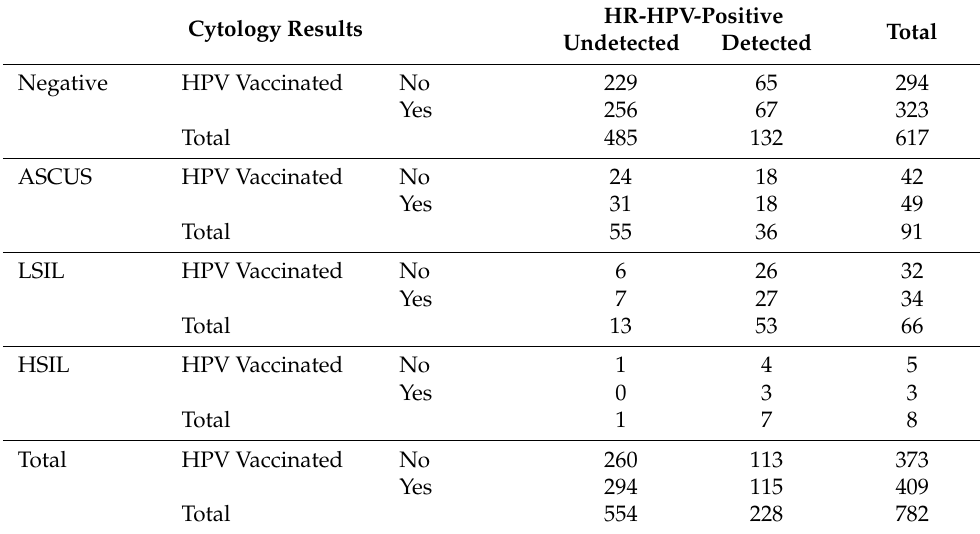
Table 6. Cytological results by specific alteration and according to vaccination